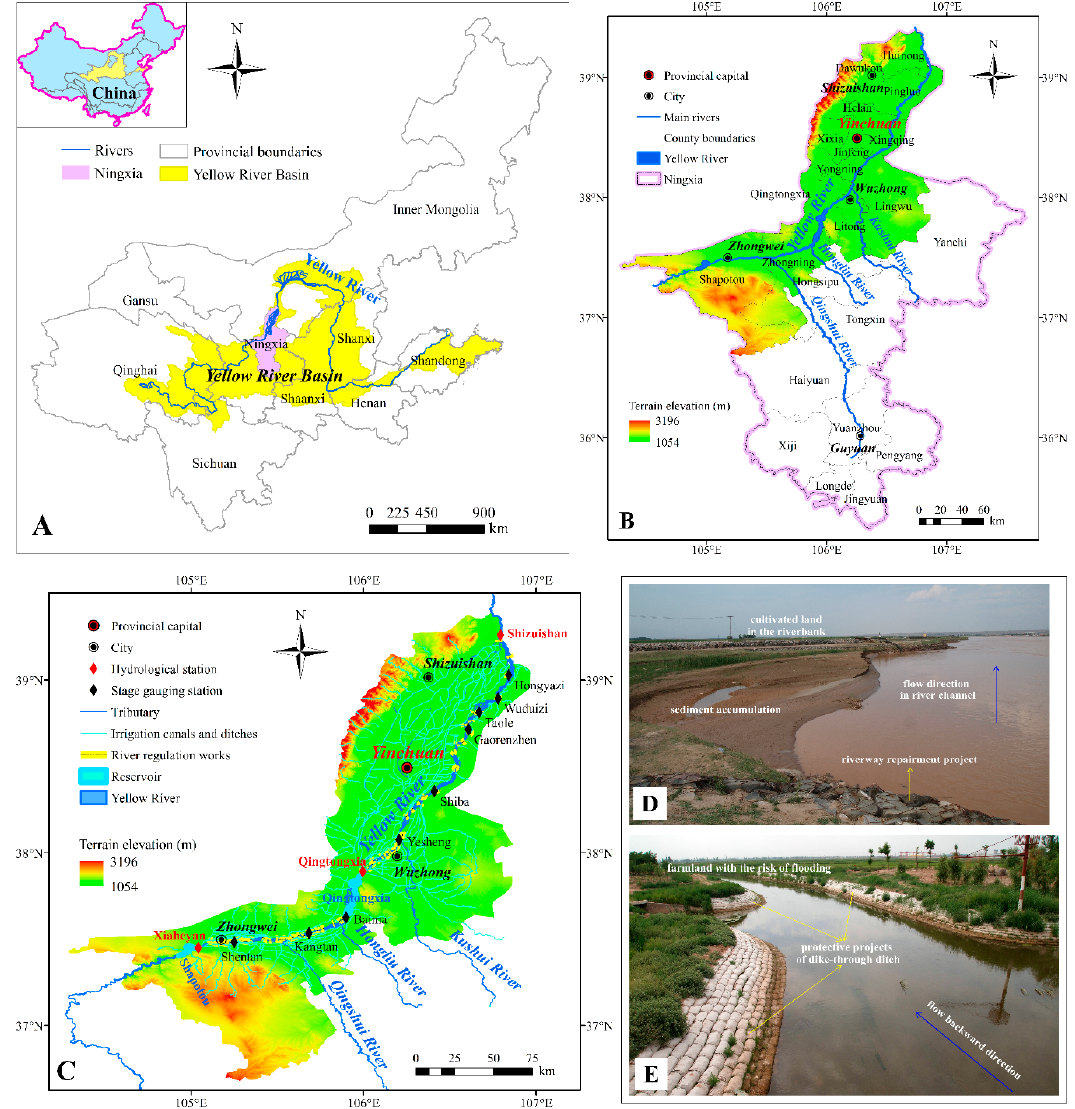
Figure 1. Geographical location map of the research area: ( A ) Yellow River Basin; ( B ) Ningxia Hui Autonomous Region; ( C ) research scope of the Ningxia Reach of the upper Yellow River (NRYR); ( D ) photos of the main river channel, bank areas, and regulation structure site; ( E ) actual scene of the typical ditches with backward flow.